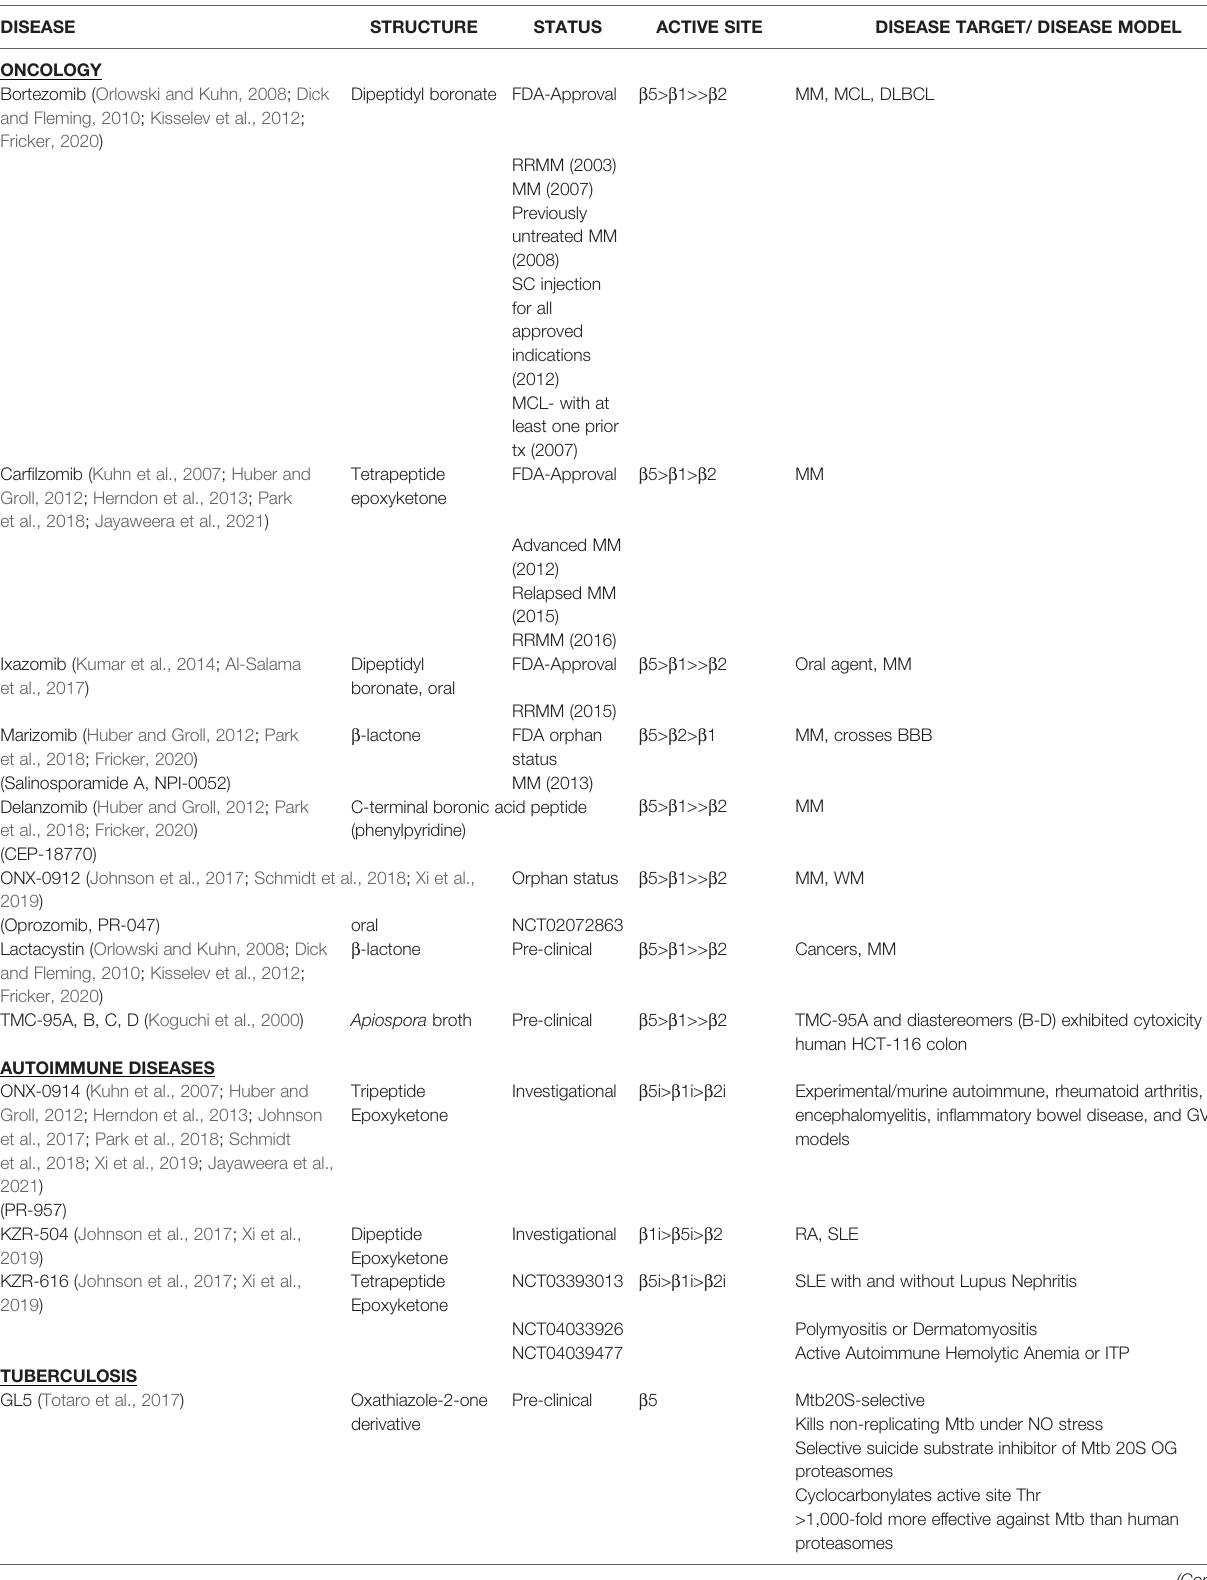
TABLE 1 | Fda-approved and investigational proteasomal inhibitors for the treatment of human